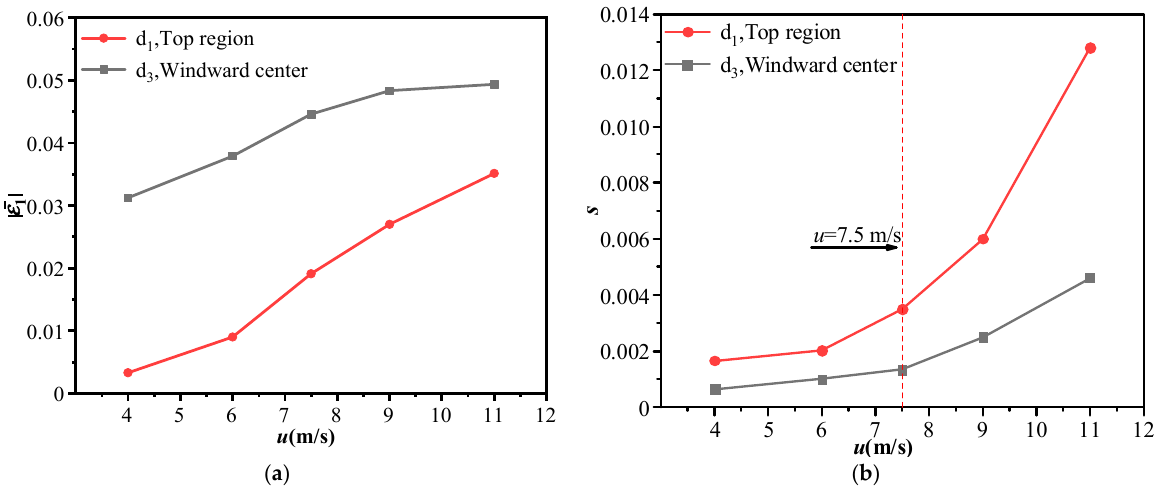
Figure 11. The curve of maximum principal strain with wind speed: ( a ) mean of maximum principal strain and ( b ) standard deviation of maximum principal strain.